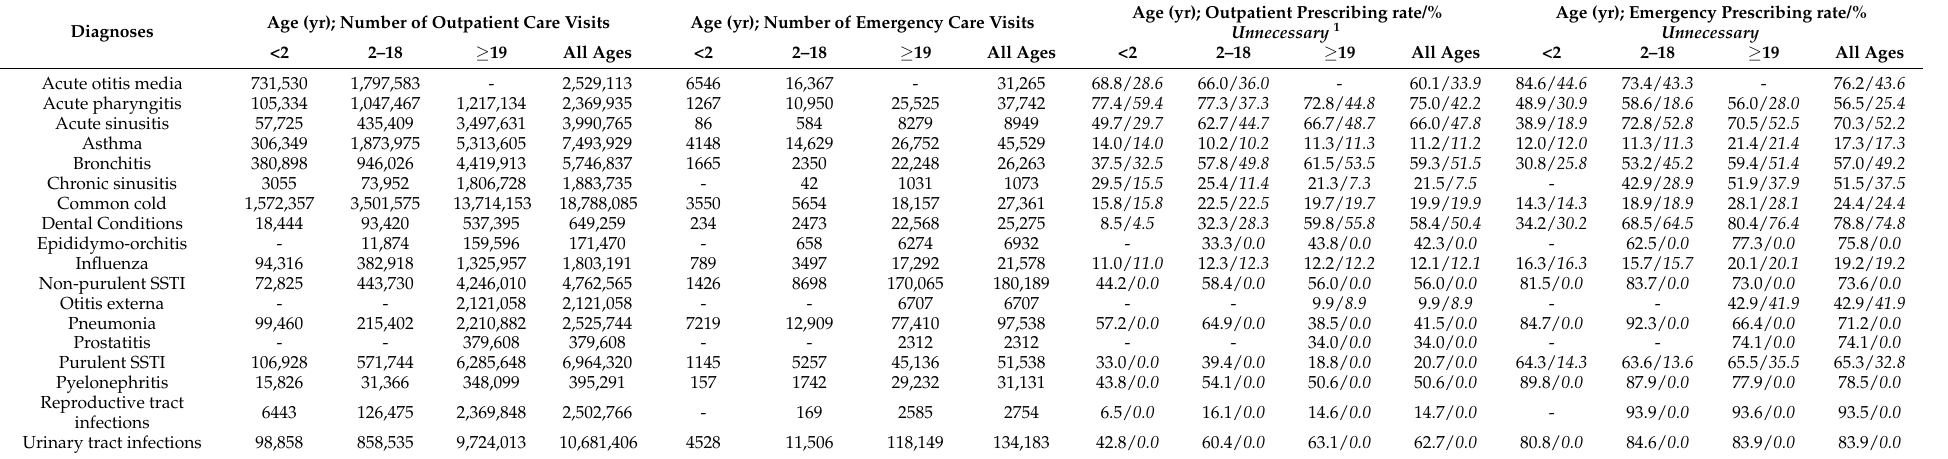
Table 3. Rate of antibiotic prescribing between outpatient and emergency care, stratified by